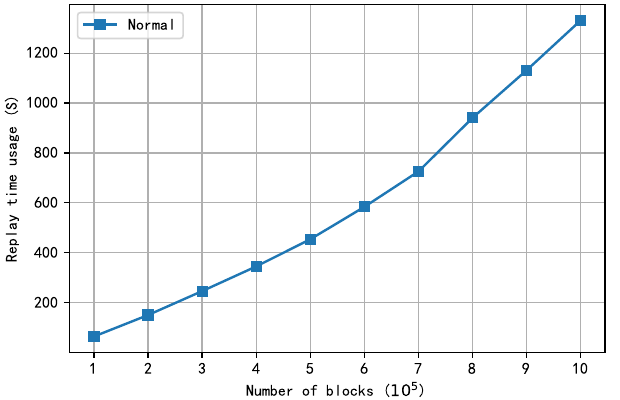
Figure 13. The time taken to replay the first million blocks in a single thread.